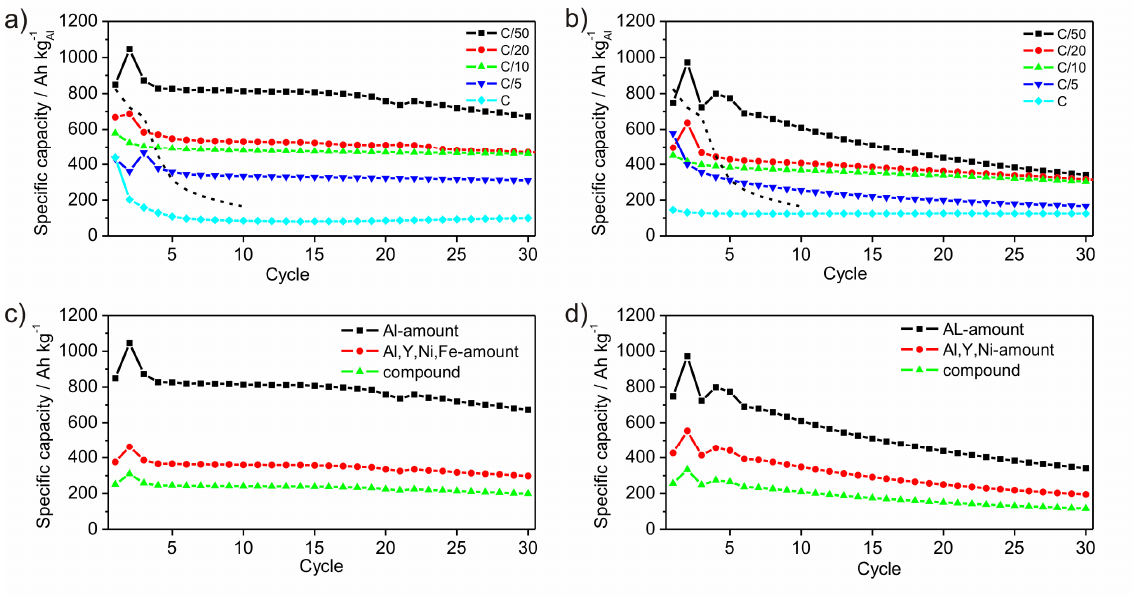
Figure 8. Development of specific capacities of ball milled amorphous Al powders P1 ( a ) and P2 ( b ), galvanostatically cycled between 0.1 V and 4 V with C-rates of C/50, C/20, C/10, C/5 and C, respectively. The dashed lines give the development of the specific capacity of crystalline Al-powder taken as reference with a particle size of 18 µm, cycled between 0.1 V and 2 V with a rate of C/50. Specific capacities at the C-rate of C/50 calculated for different active masses for P1 ( c ) and P2 ( d